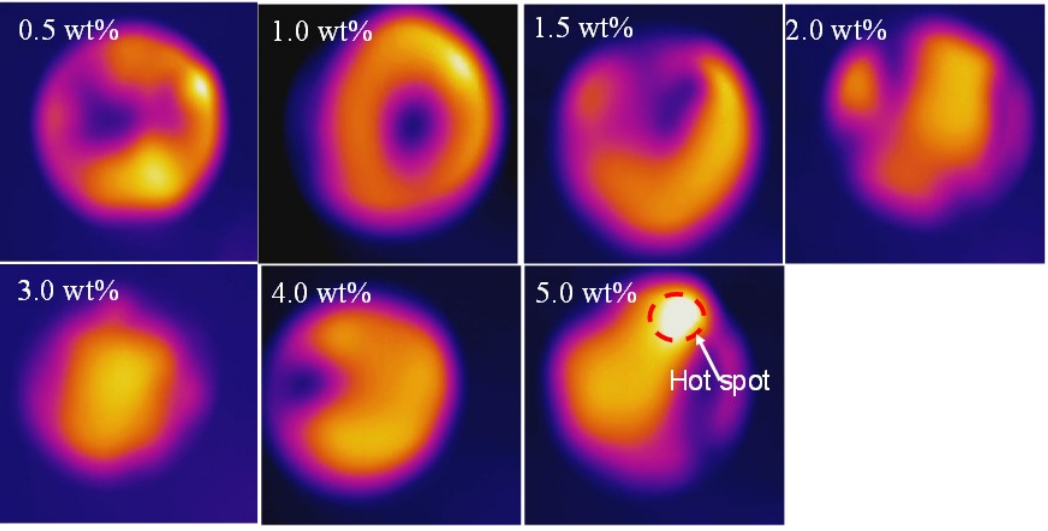
Figure 9. Infrared images of the composite films with different mass contents of graphene via IR light.